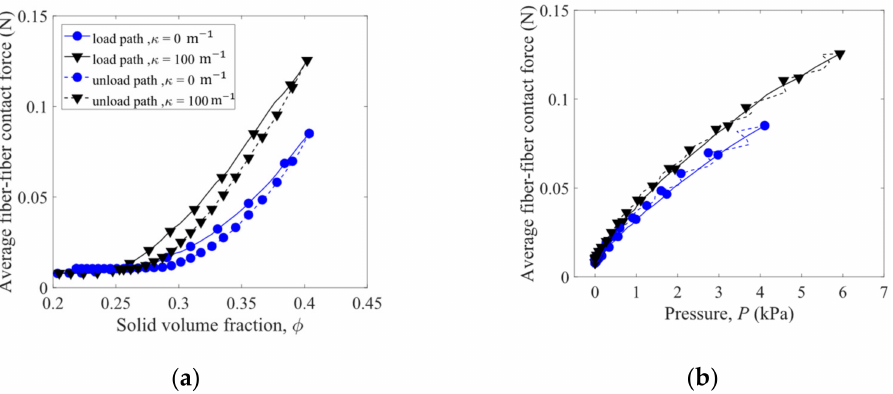
Figure 10. Variation of average fiber–fiber contact force with ( a ) solid volume fraction and ( b ) pressure in the load–unload cycle 1.